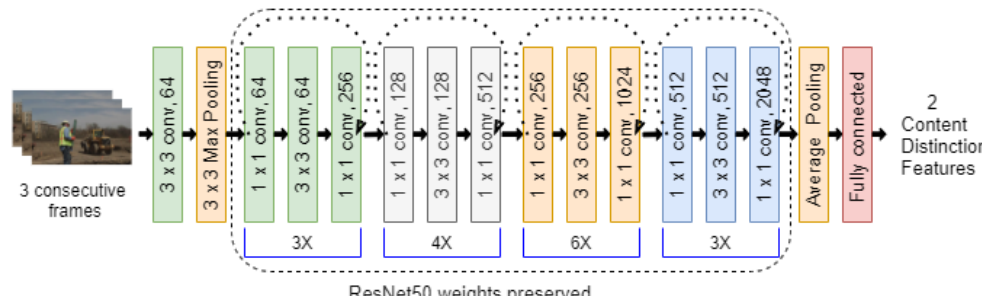
Figure 4. Self-supervised content distinction